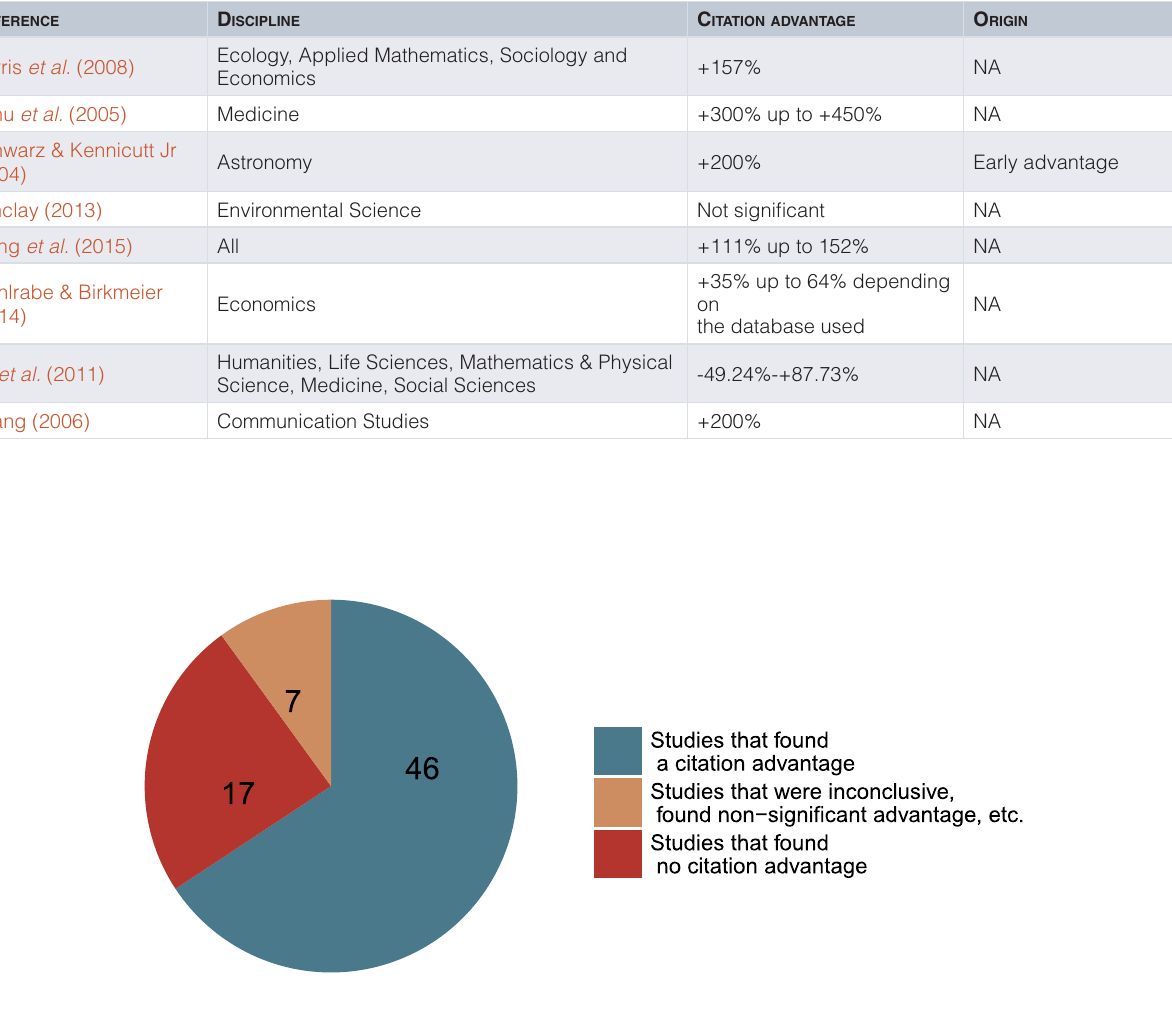
Figure 2. Studies that investigated the citation advantage grouped by their conclusion. The majority concluded that there is a significant citation advantage for Open Access articles. Source: Data from The Open Access Citation Advantage Service, SPARC Europe, accessed March